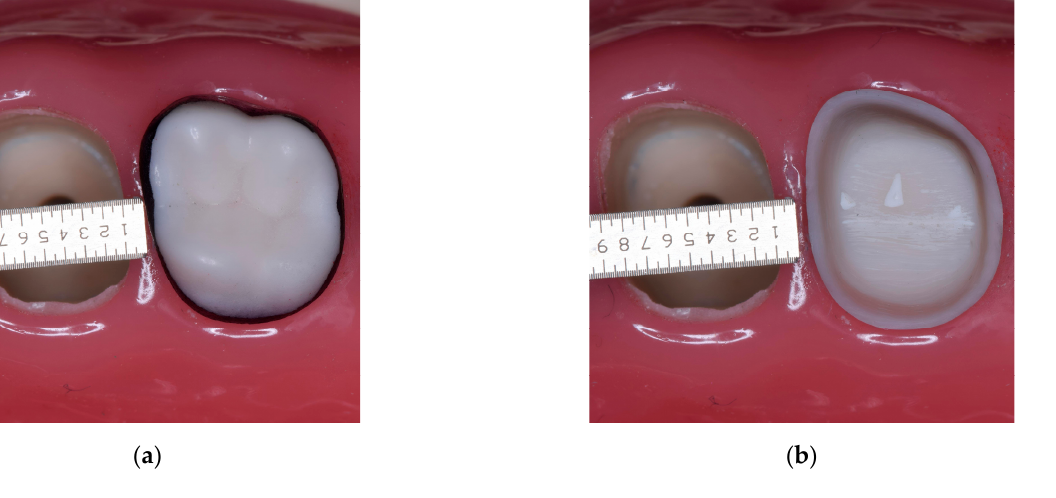
Figure 1. The upper second molar on the cast ( a ) The prosthetic equator, marked with a black pencil; ( b ) The calibration of the digital